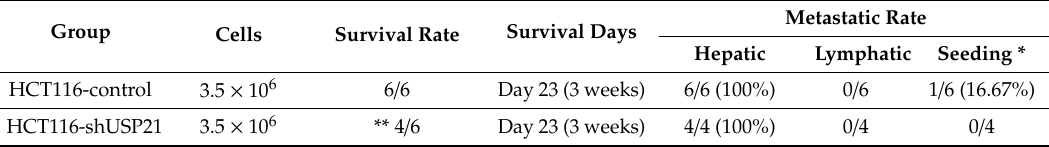
Table 2. Tumorigenesis rate from intrasplenic